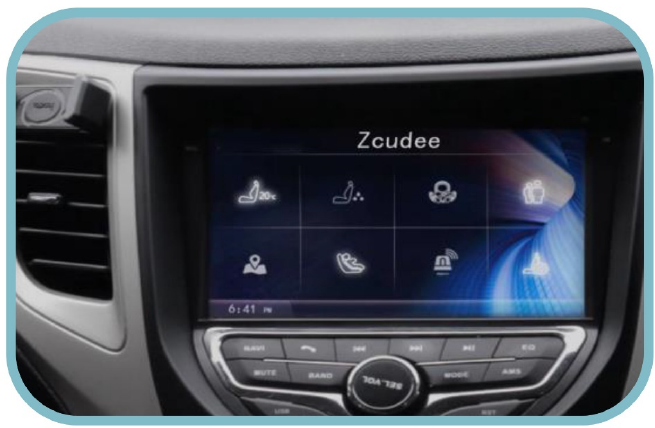
Figure 10. The central control panel of vehicles.